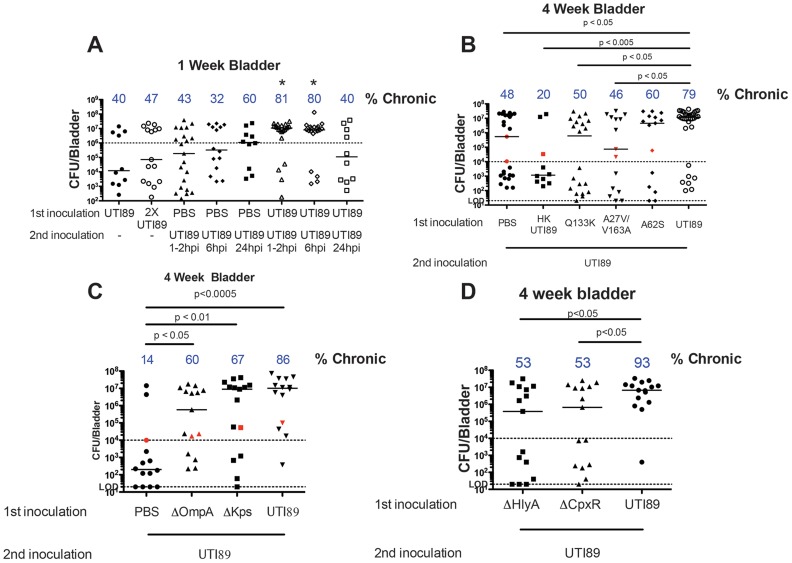
Superinfections of C3H/HeN mice.
A) Mice were infected with 107 CFU UTI89, 2×107 CFU UTI89, or PBS and re-infected with UTI89 at the indicated time points. One week total bladder titers are shown. Percentage of mice likely to develop chronic cystitis is displayed at the top of the column based on a CFU cutoff of 106. Asterisks indicate p<0.05 from the PBS control and singly infected mice. B–D) Mice were infected with the indicated strain or PBS and re-infected one hour later. Urine titers were determined over time and four-week bladder titers are displayed. The fraction of mice with chronic cystitis is displayed at the top of each column. Red data points indicate resolved infection. Horizontal bars indicate median values. The dashed line at 20 CFU represents the LOD, and the dashed line at 106 (A) or 104 CFU (B–D) represents the chronic cystitis cutoff for urine and bladder titers. Panel A reflects 2–4 experiments with 5–9 mice per group. Panel B is 2–7 experiments with 4–5 mice per group. Panel C–D are 3 experiments with 4–5 mice per group. Statistical comparisons were determined using Fisher's exact test based on the fraction of mice experiencing chronic cystitis.